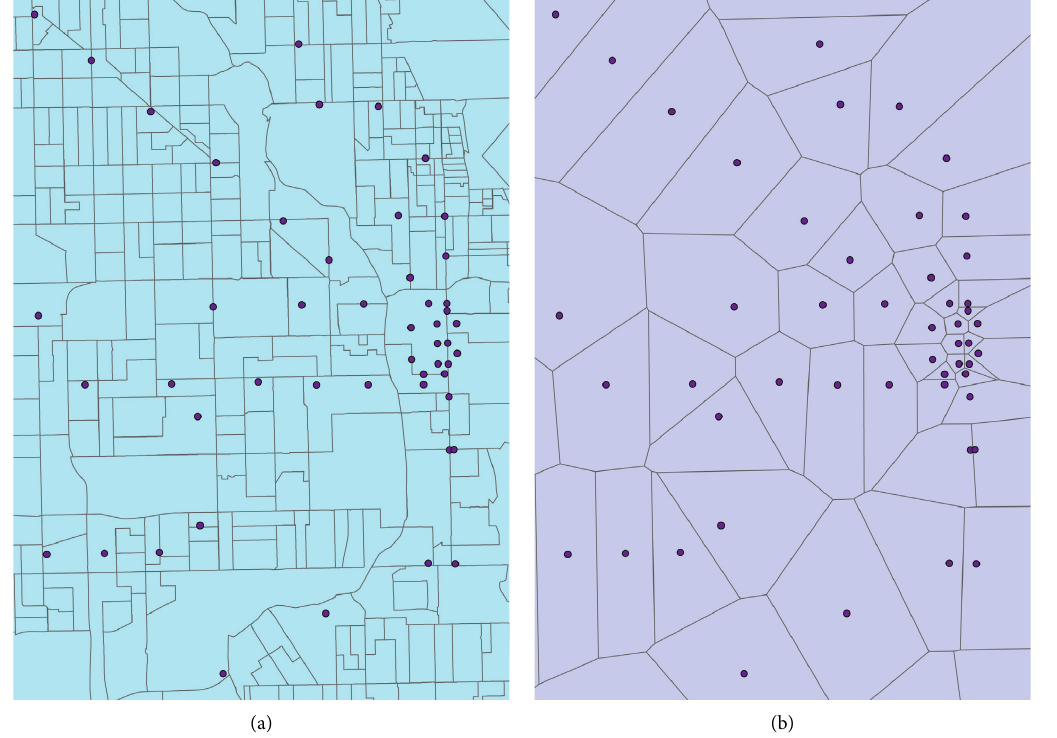
Figure 5: Chicago transit stations (a) and Thiessen polygons